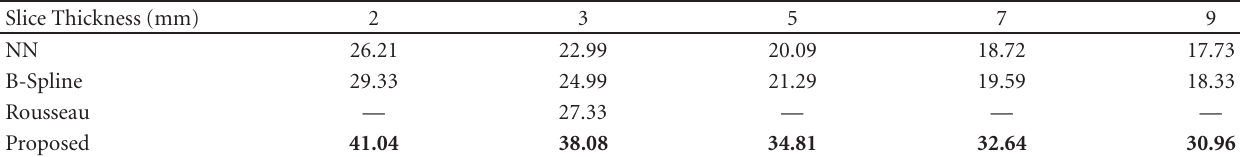
Table 2: PSNR values of the di ff erent methods compared for several slices thicknesses for the multiple sclerosis anatomy case. Slice Thickness